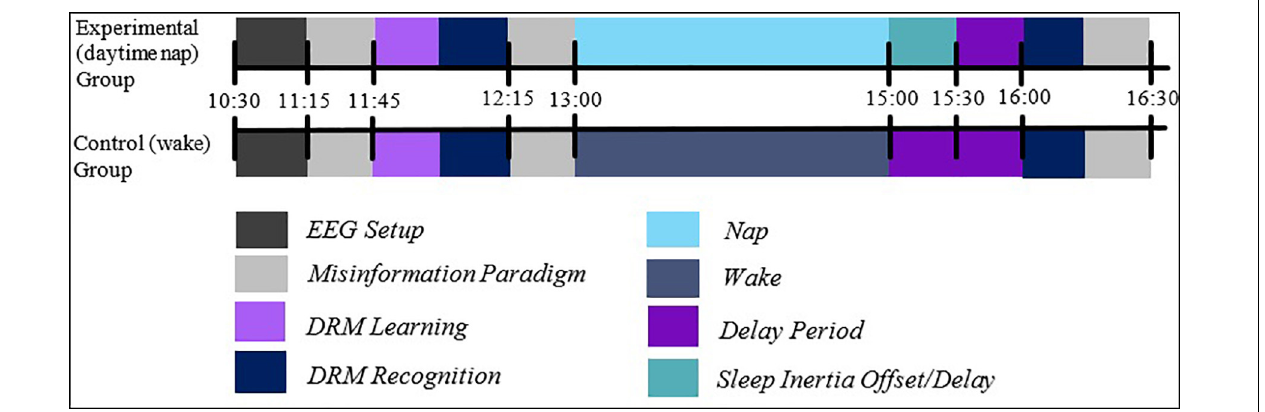
FIGURE 2 | The experimental procedure. Participants were fitted with EEG caps and undertook learning of DRM lists, before being tested for immediate recognition and, following a sleep/wake retention interval, delayed recognition. Note that both IR and DR periods involved the presentation of associative theme words. Also note the presence of a misinformation task, which was unrelated to the present